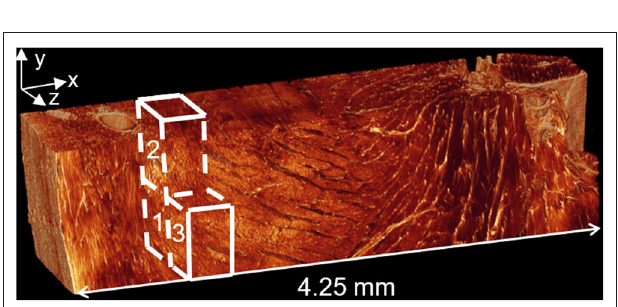
FIGURE 3 | Confocal microscopy image of left ventricular tissue slice from a rat. Adjusted with permission from Sands et al. ( 58).